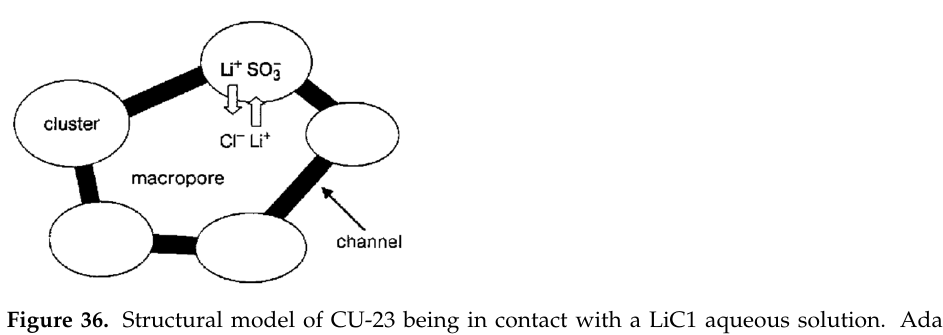
Figure 35. Dependence of the water self-diffusion coefficients (curves 2–4 and 8) and Li + counterion self-diffusion coefficients (curves 1, 5–7 and 9) on λ , where n is the number of water molecules per one Li + ion. Curve 1, Li + in a LiCl aqueous solution; curve 2 and ∆ , water in KU-23 without an external electrolyte; curve 3 and ○ , water in KU-23 equilibrated with a LiCl aqueous solution; curve 4 and ●, water in KU-23 equilibrated with a LiOH aqueous solution; curve 5, Li + in KU-23 equilibrated with a LiCl aqueous solution; curve 6, Li + in KU-23 equilibrated with a LiOH aqueous solution; curve 7, Li + in KU-23 without an external solution; curve 8, water in a Nafion-type membrane without an external solution: curve 9, Li + in a Nafion-type membrane equilibrated with a LiCl aqueous solution. Adapted from [77].